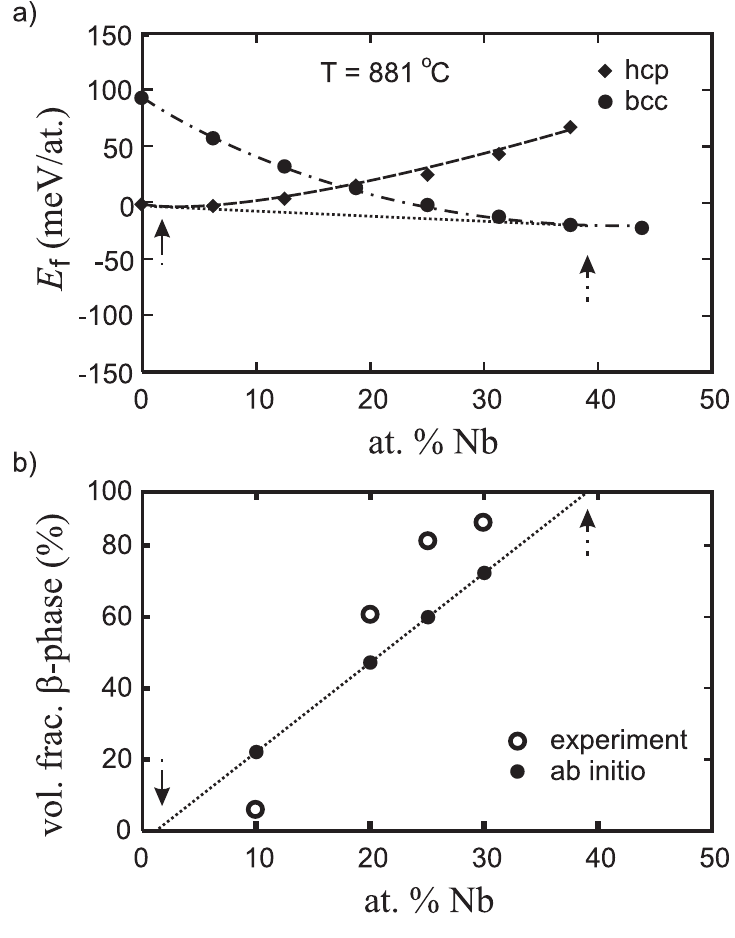
for the hcp/bcc f